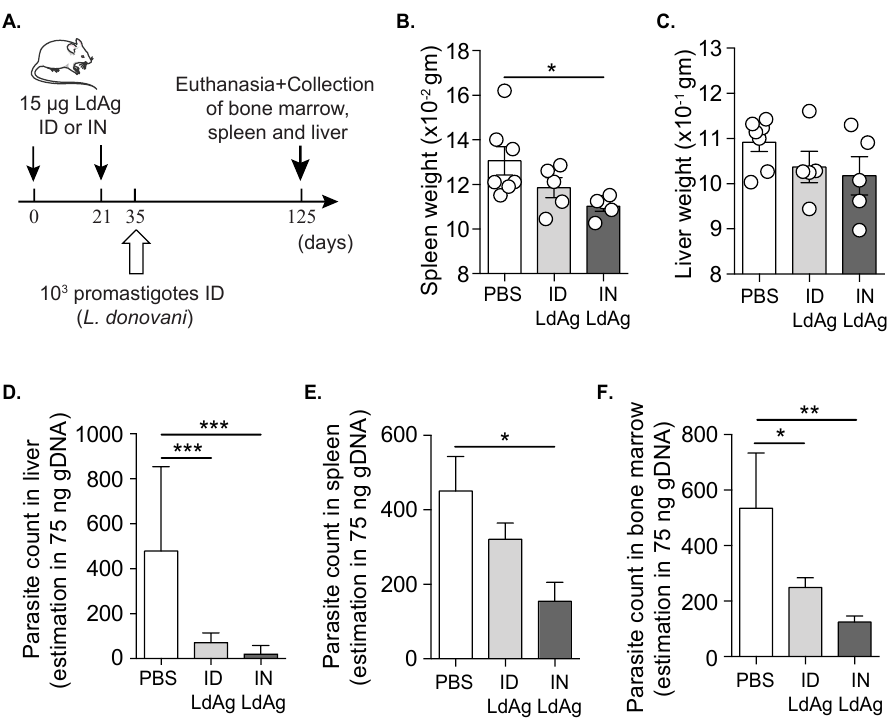
Fig 2. LdAg-based prophylactic vaccine decreases Leishmania parasitic burden. (A) Scheme representing the prophylactic vaccine protocol against VL. All mice groups were infected; PBS group represents non-vaccinated mice, ID LdAg group represents intradermally vaccinated mice and IN LdAg represents intranasally vaccinated mice. Mouse image is from smart.servier.com. (B, C) Spleen (B) and liver (C) weights measured immediately after dissection of different mice groups. (D-F) The effect of ID and IN LdAg vaccine on L . donovani parasite count in livers (D), spleens (E) and bone marrows (F) estimated by qPCR in 75 ng of tissue gDNA. Data are representative of two independent experiments and are presented as means ± SEM ( n = 5–7; one-way